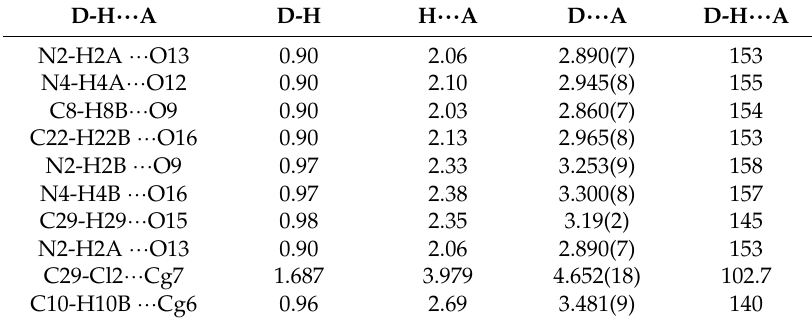
Figure 6. View of the 2D supramolecular structure of complex 2 showing the N-H···O, C-H···O